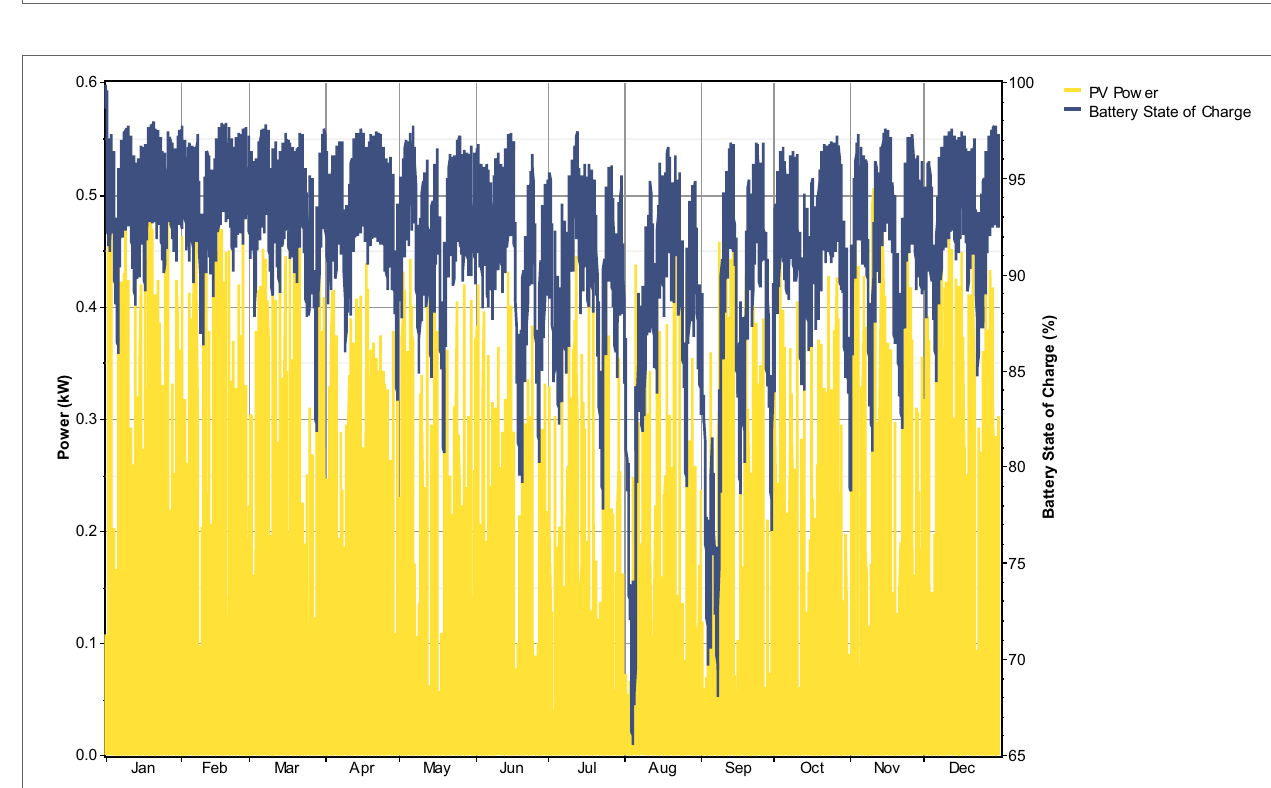
FigUre 7 | comparison of three variables (PV power, excess electricity, and battery state of charge) .